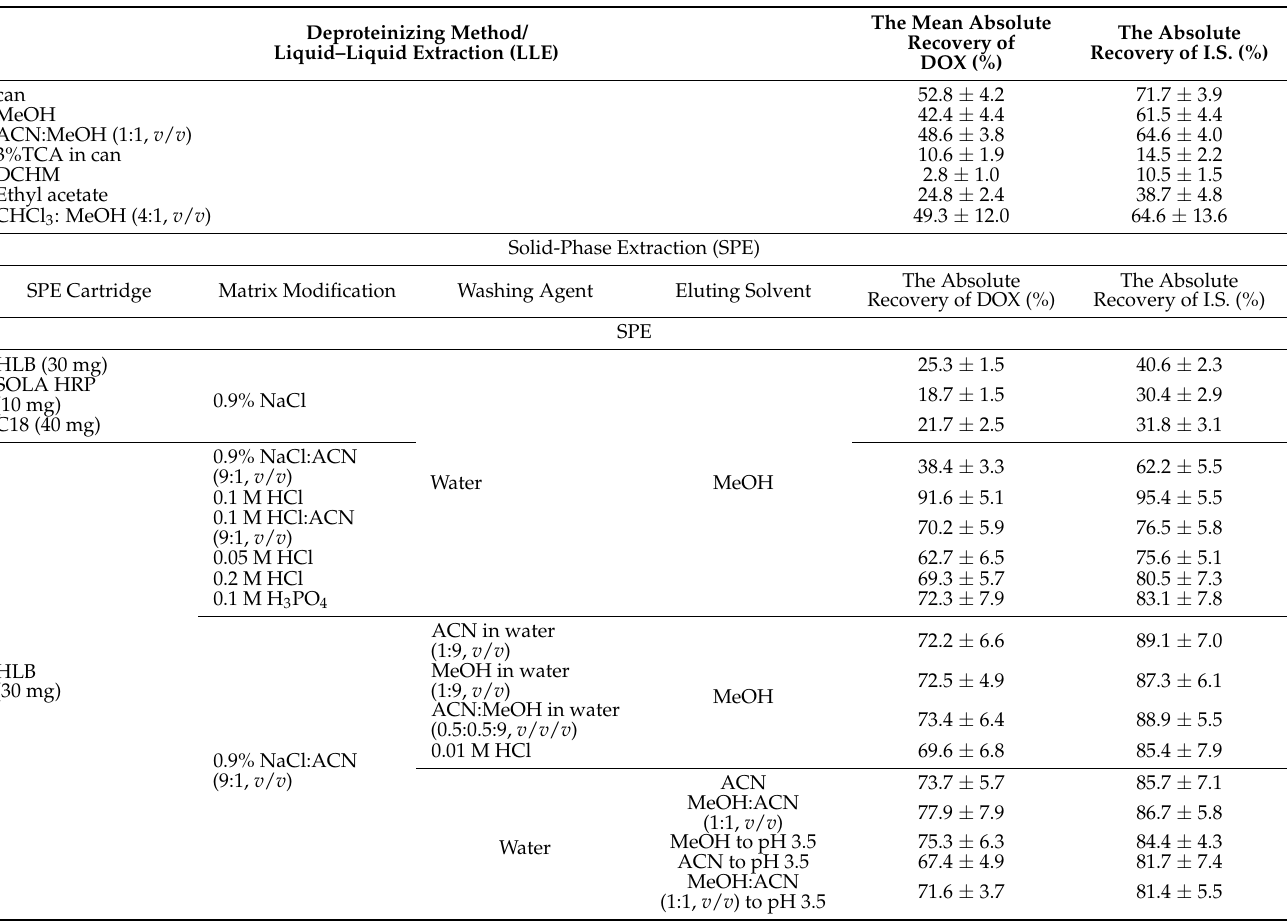
Table 1. Absolute extraction efficiencies of DOX isolated from rat liver tissue using different sample- preparation methods ( n =